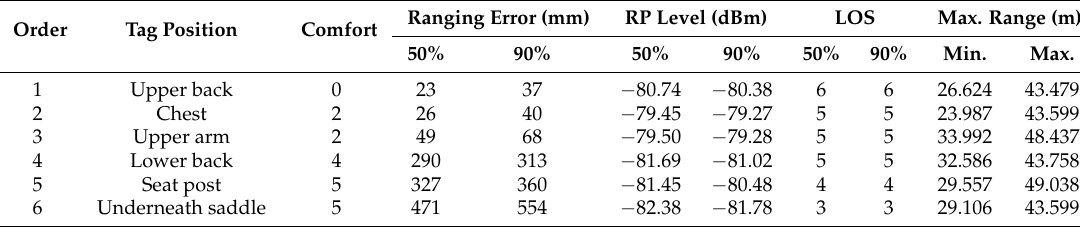
Table 5. Overview of the results; anchor height: 1.5 m.